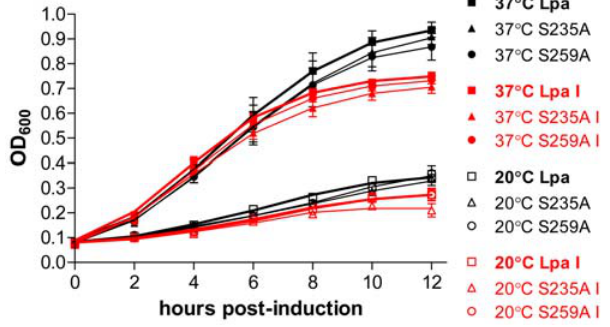
Figure 5. Growth of lipoylation deficient E.coli expressing Lpa and Lpa active site mutants. Growth assay of TM136 strain cells [16] expressing Lpa (squares), Lpa S235A (upward triangles), and Lpa S259A (circles). Growth curves at 37 u C (solid symbols) and 20 u C (open symbols are shown with cultures induced with 0.4 mM IPTG highlighted in red. In each condition, the growth curve corresponding to cells expressing wild type Lpa is shown with a thickened line.